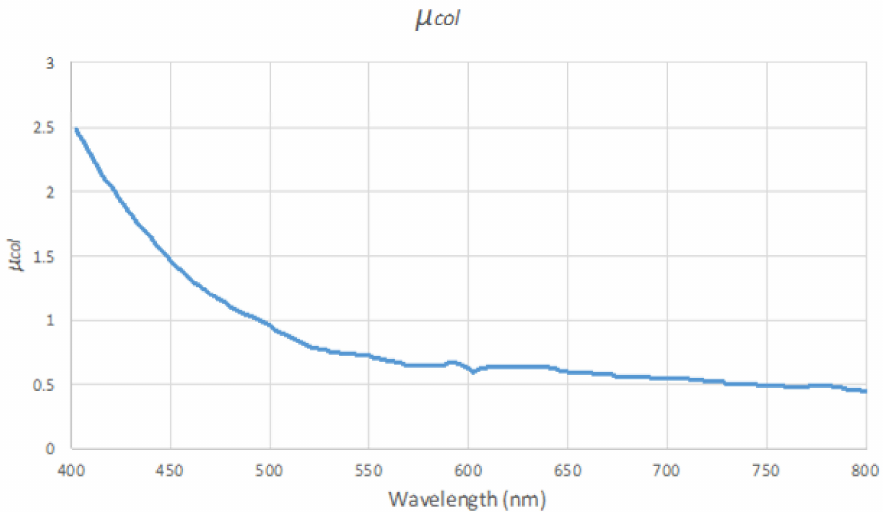
Figure 2. The absorption coe ffi cient spectrum of pure collagen